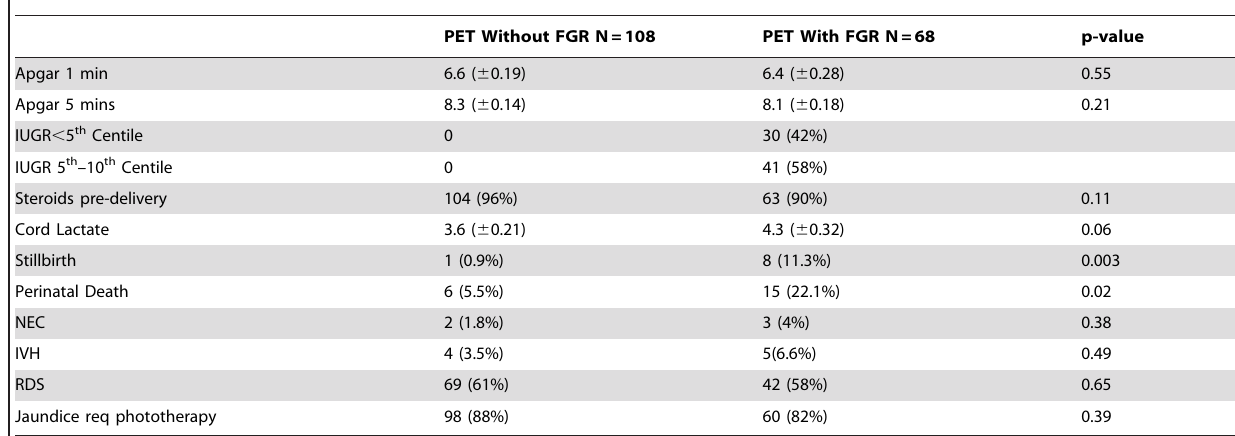
Table 4. Neonatal Outcomes.